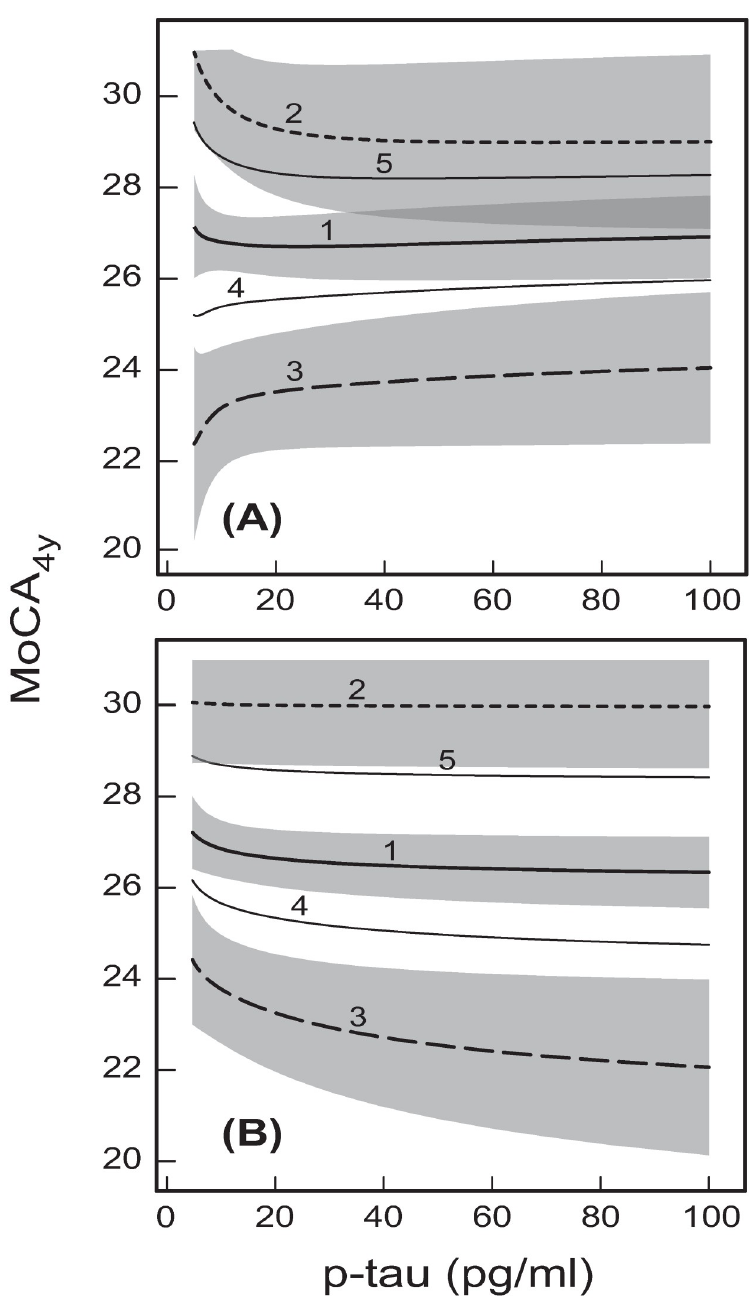
Fig 6. The predicted dependences of MoCA 4y on baseline CSF concentration of p-tau. The dependences result from the GSEM networks with: (A ) CSF p-tau as the predicting protein variable (Fig 1A and 1B); and (B ) CSF A β 1–42 as the predicting protein variable (Figs 1A and 2). The curves are presented for the following baseline ages: (1) Age = 60 years; (2) Age = 40 years; (3) Age = 80 years; (4) Age = 70 years; and (5) Age = 50 years. The shaded bands indicate the 95% prediction intervals for the three curves 1, 2 and 3. For ease of visual perception, the prediction intervals are not shown for curves 4 and 5. The other variables for these graphs were either taken at their mean/base values: DaT = 1.38, Education = 15.64 years, Gender = Male, and GDS = 2.30 for (A) and (B), and also average (A β 1–42 ) 1/2 = 18.95 (A β 1–42 = 359.10 pg/ml) for (B), or were predicted by the effect paths in the developed models (Figs 1A, 1B and 2).